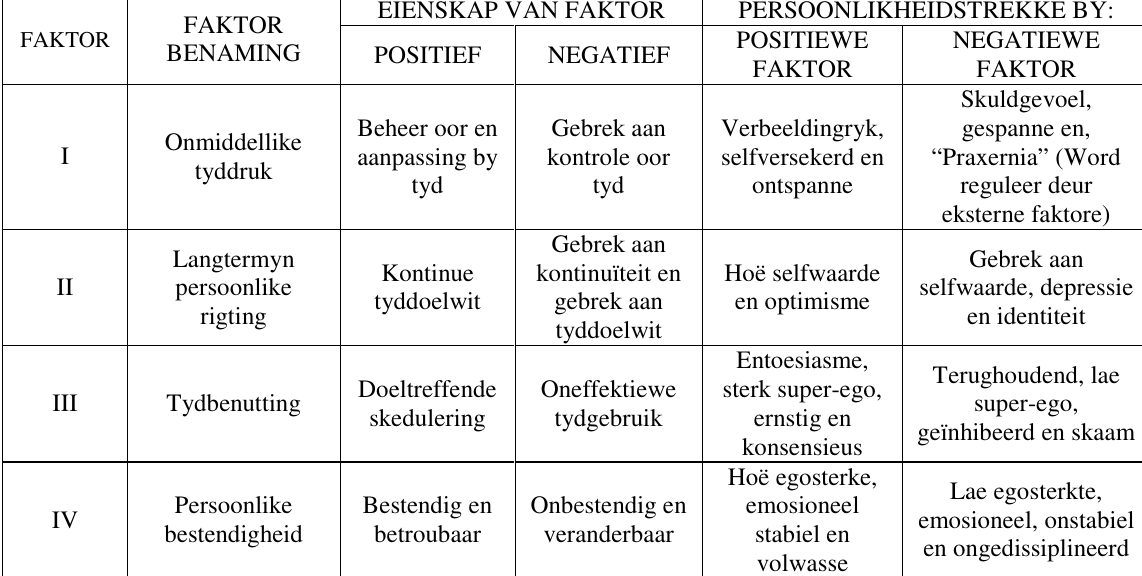
Figuur 1. Die verband tussen die subjektiewe ondervinding van tyd en persoonlikheidstrekke volgens die studie van Wessman